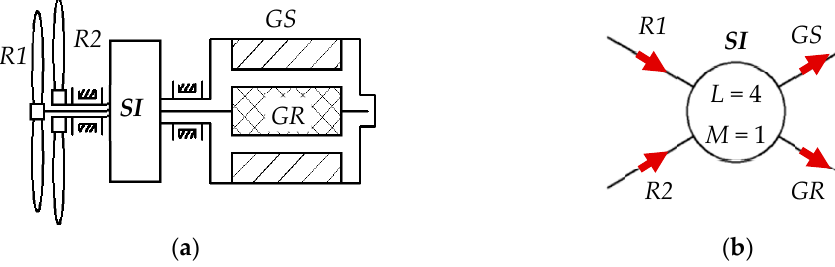
Figure 1. Counter-rotating wind turbine with counter-rotating electric generator: ( a ) general conceptual scheme; ( b ) block scheme of the speed increaser ( SI ) with two inputs and two outputs ( R 1—main wind rotor, R 2—secondary wind rotor, GR —electric generator rotor, GS —electric generator stator, L —number of mechanism inputs and outputs, M—mechanism degree of freedom).